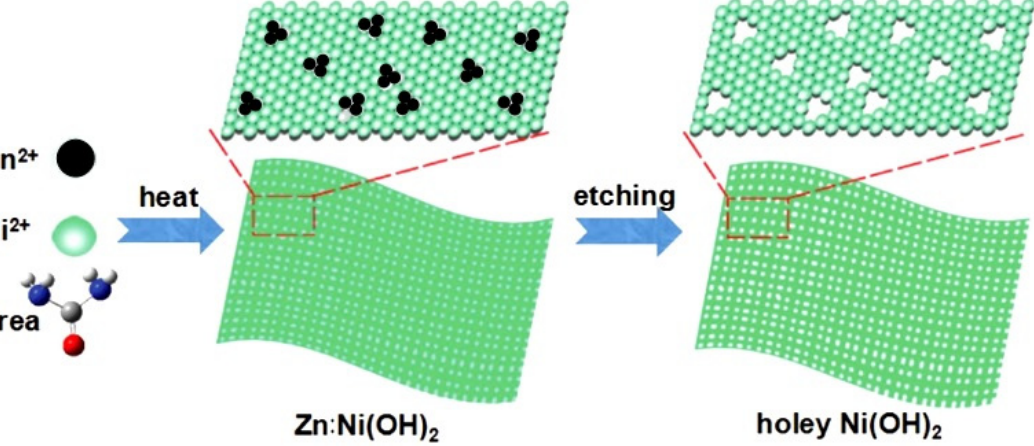
Figure 6. TEM images of MnO 2 nanosheets after annealing in air at different temperatures: ( a ) as ‐ synthesized, ( b ) T an = 300 °C, ( c ) T an = 400 °C, ( d ) T an = T an = 500 °C, ( e ) T an = 600 °C, ( f ) T an = 700 °C. Reprinted with permission from Adpakpang et al. [73]. Copyright 2018: Wiley.